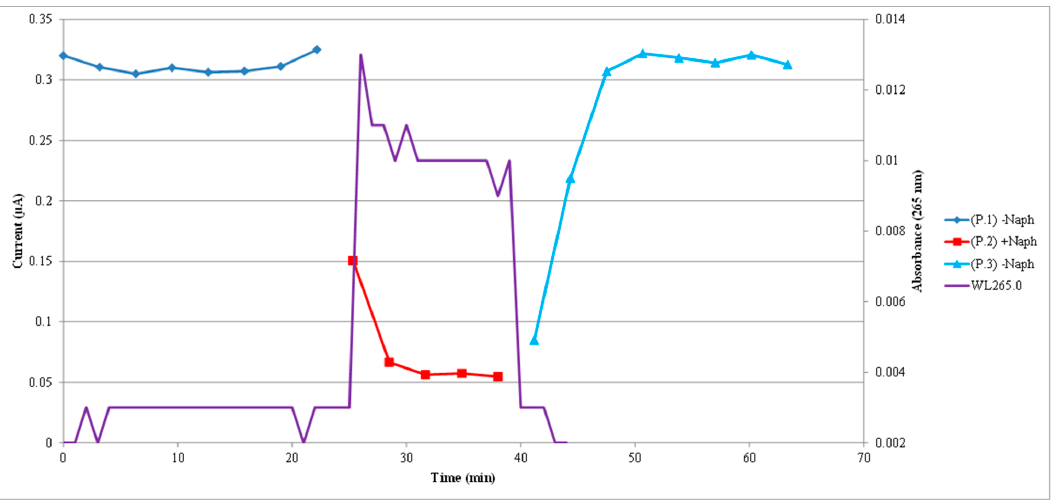
Figure 4. Typical sensor current response to one cycle of naphthalene contamination and cleaning. Micro-amp sensor current and absorbance measurements were made simultaneously. P1 corresponds to the initial fresh air introduction (baseline phase), P2 corresponds to naphthalene + air introduction (contamination phase), and P3 corresponds to the re-introduction of fresh air only (cleaning phase). The sensor current values can be read on the left-hand scale of the y -axis. The purple line (WL265.0) corresponds to the absorbance at 265 nm for naphthalene. Absorbance values can be read on the right-hand scale of the y -axis. An increase in absorbance corresponds to an increase in naphthalene concentration. Color lines with markers indicate sensor current measurements every 3 min. The purple line appears to be continuous because the spectrophotometer made absorbance measurements every minute. Sensor current decreased as naphthalene concentration increased.